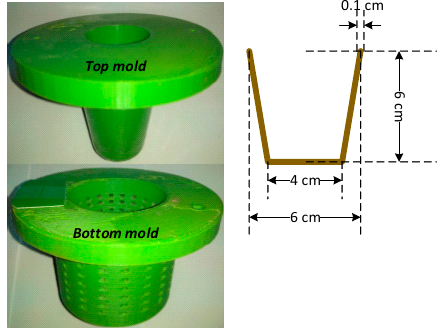
Figure 2. Mold used to form seedling pot.